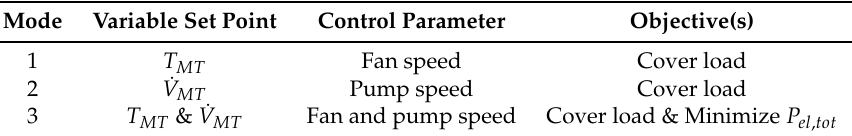
Table 1. Overview of the investigated control